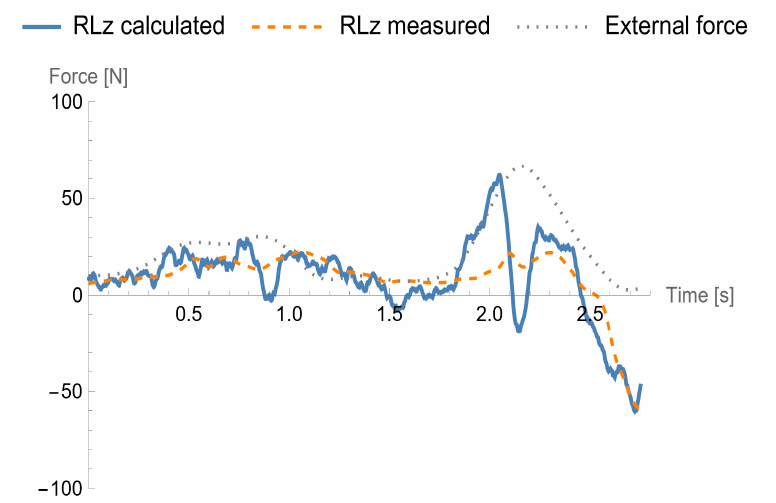
Figure 11. The in-plane component, RL z , of the GRF for the left foot in the case of the external force- caused fall with two pulls. The RL z measured with the dynamometric plate is drawn using the dashed line, and the RL z calculated is drawn using the solid line. The dotted line presents the time course of the external force magnitude.